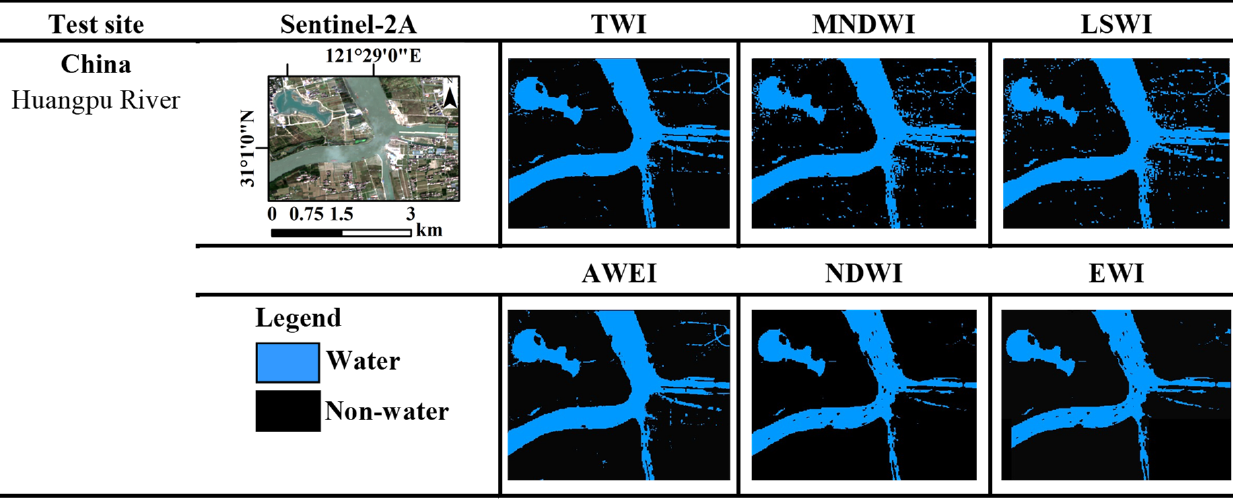
Figure 9. Comparison of water extraction results using seven different water indices at the Huangpu River site in Shanghai, China. Sentinel-2A color composite, bands 4, 3, 2 coded RGB.